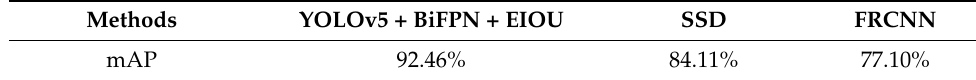
Table 3. Comparison of the mAP of YOLOv5 and other methods.